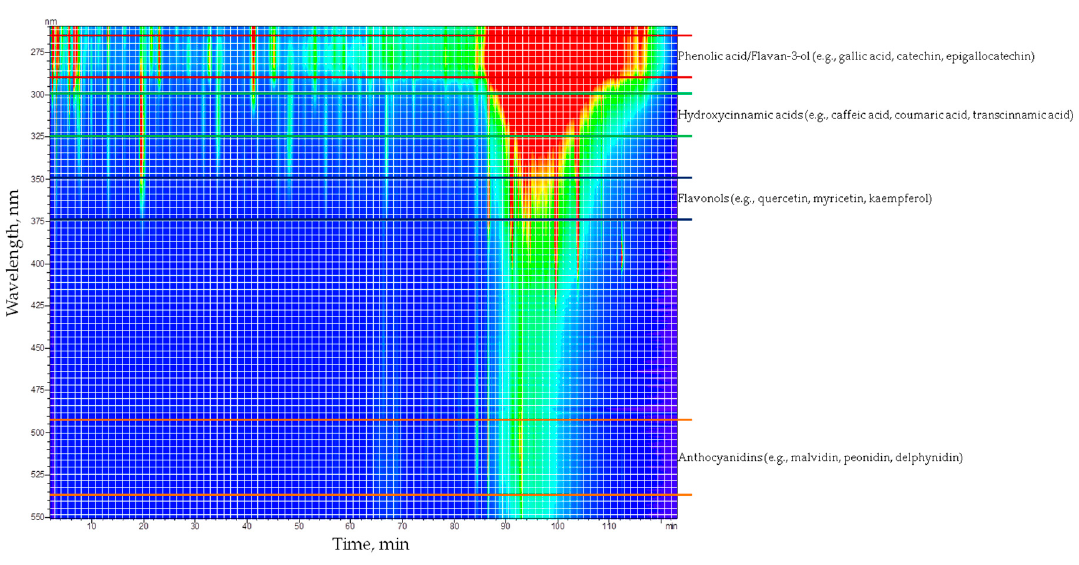
Figure 1. Spectrochromatogram of the PRPE from Nebbiolo’s grapes divided in sections corresponding to different polyphenol (Pph) classes. Table 2. Quantification of four di ff erent polyphenol molecules through HPLC analysis. Gallic Acid Quercetin Rutin Malvidin-3-Glucoside PRPE (mg / L) (mg / L) (mg / L) (mg / L) Nebbiolo 19.43 66.46 38.45